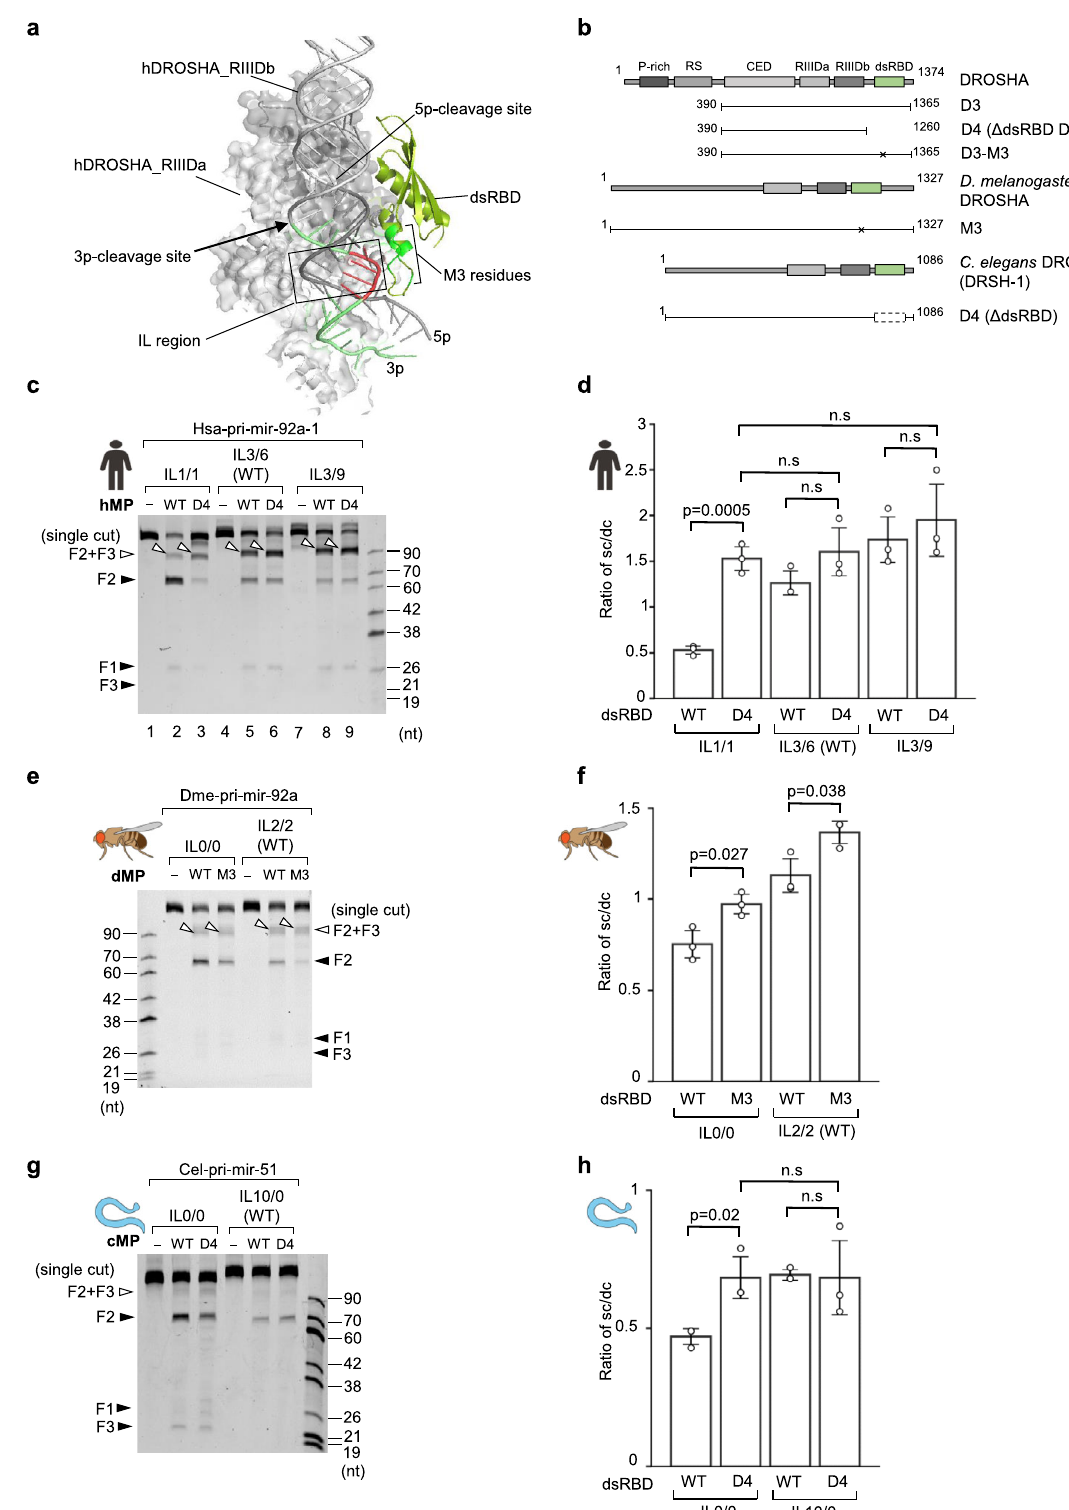
We compared the 5p-strand single cleavage levels of wild-type (WT) and dsRBD-deleted (D4) MP complexes (Fig. 4b and Supplementary Fig. 4a) and found that the latter signi fi cantly increased the ratio of 5p-strand single-to-double cleavages in hsa- pri-mir-92a-1 IL1/1 (Fig. 4c, lanes 2 and 3; and Fig. 4d). As hsa- pri-mir-92a-1 IL1/1 contained a small IL, the interaction between its lower stem and dsRBD was expected to be retained.